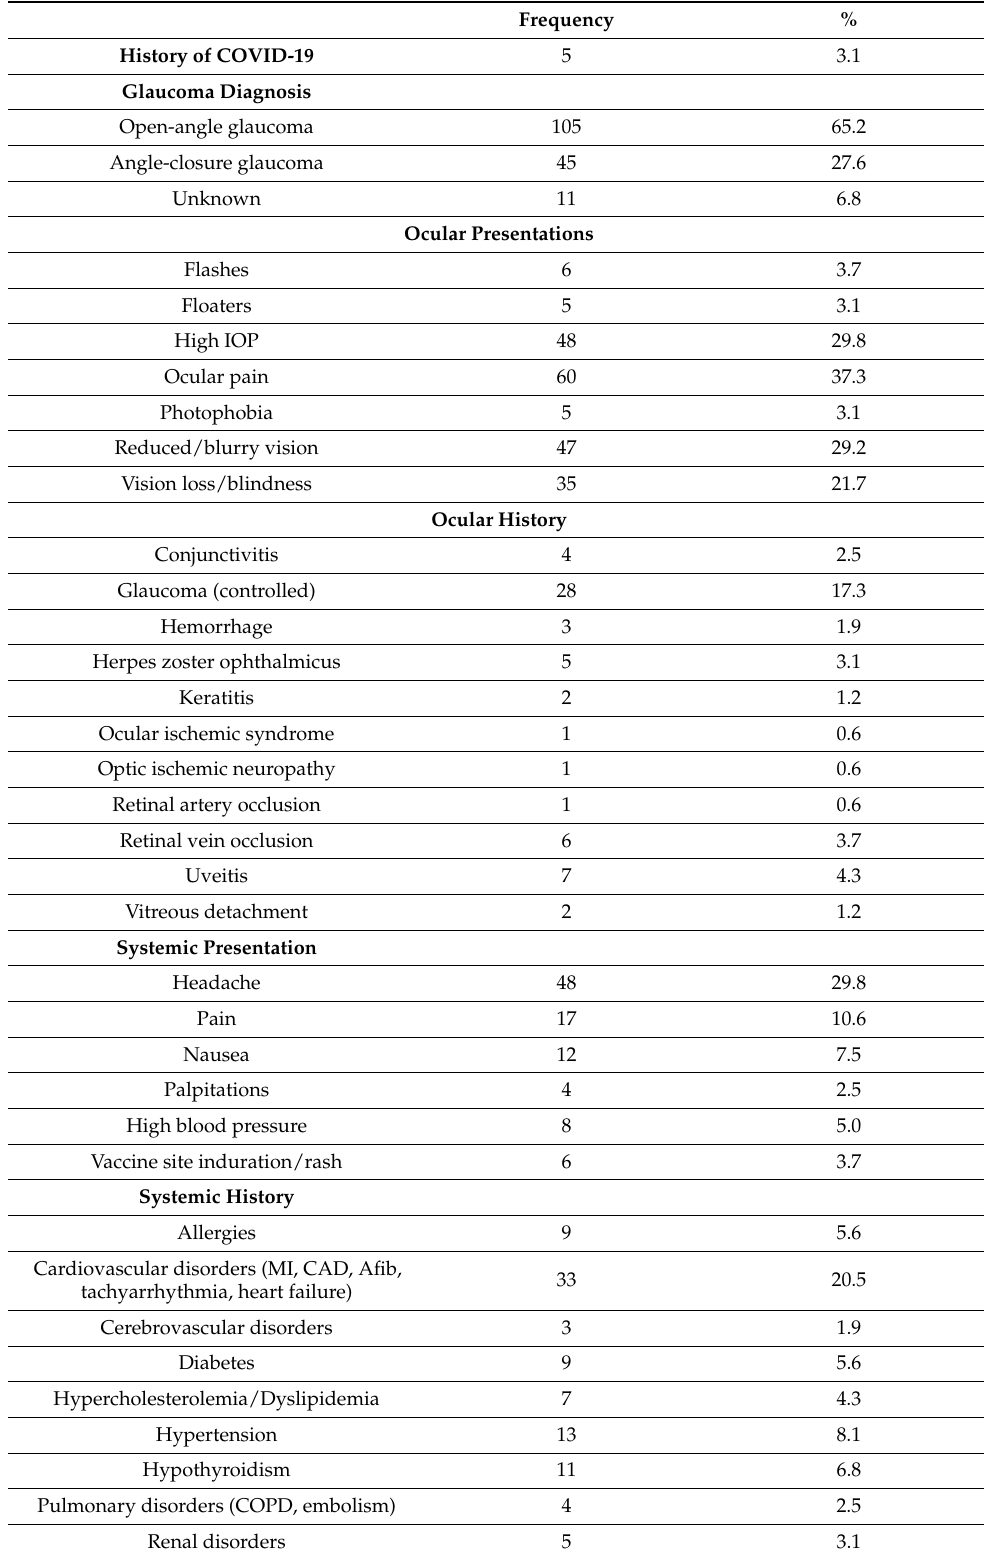
Table 3. Ocular and systemic history and presentation in patients diagnosed with glaucoma following SARS-CoV-2